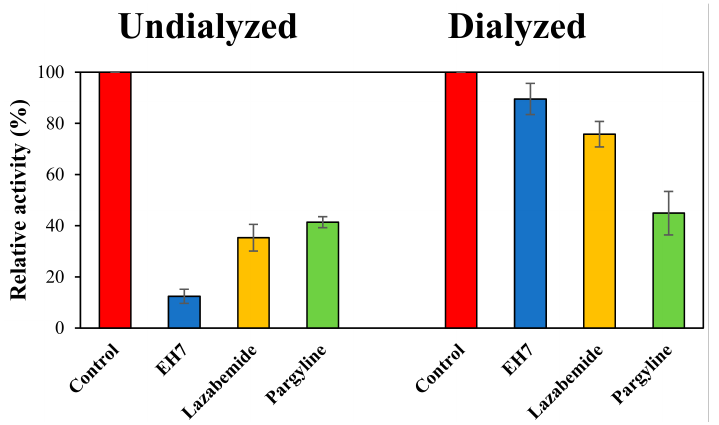
Figure 4. Recovery of MAO-B inhibition by EH7 , using dialysis experiments. The concentrations used were EH7 at 0.15 µ M, lazabemide (a reversible reference inhibitor) at 0.20 µ M, and pargyline (an irreversible reference inhibitor) at 0.30 µ